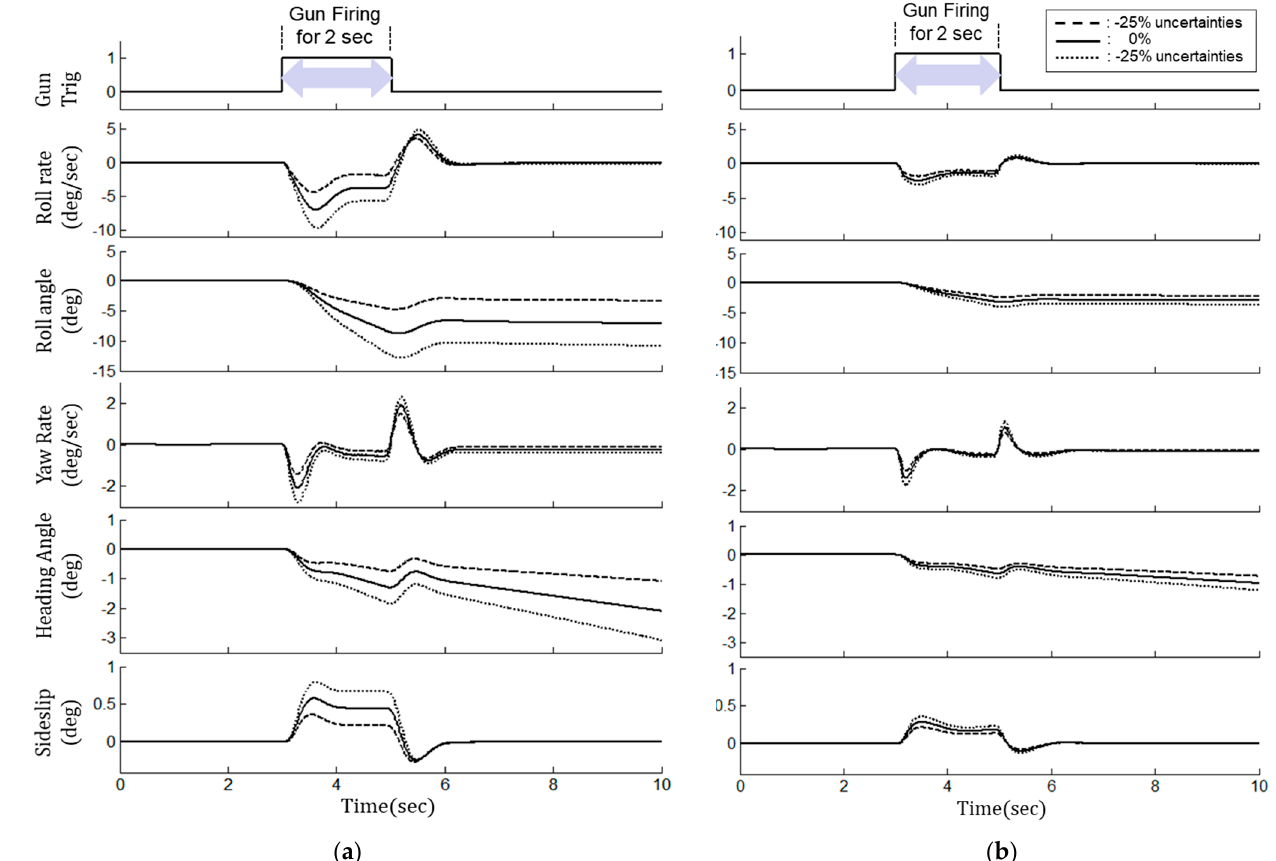
Figure 12. Result of robustness in gun firing moment uncertainties for each control method at M0.9, 30 kft altitude: ( a ) gun compensation control; ( b ) additional augmentation control.